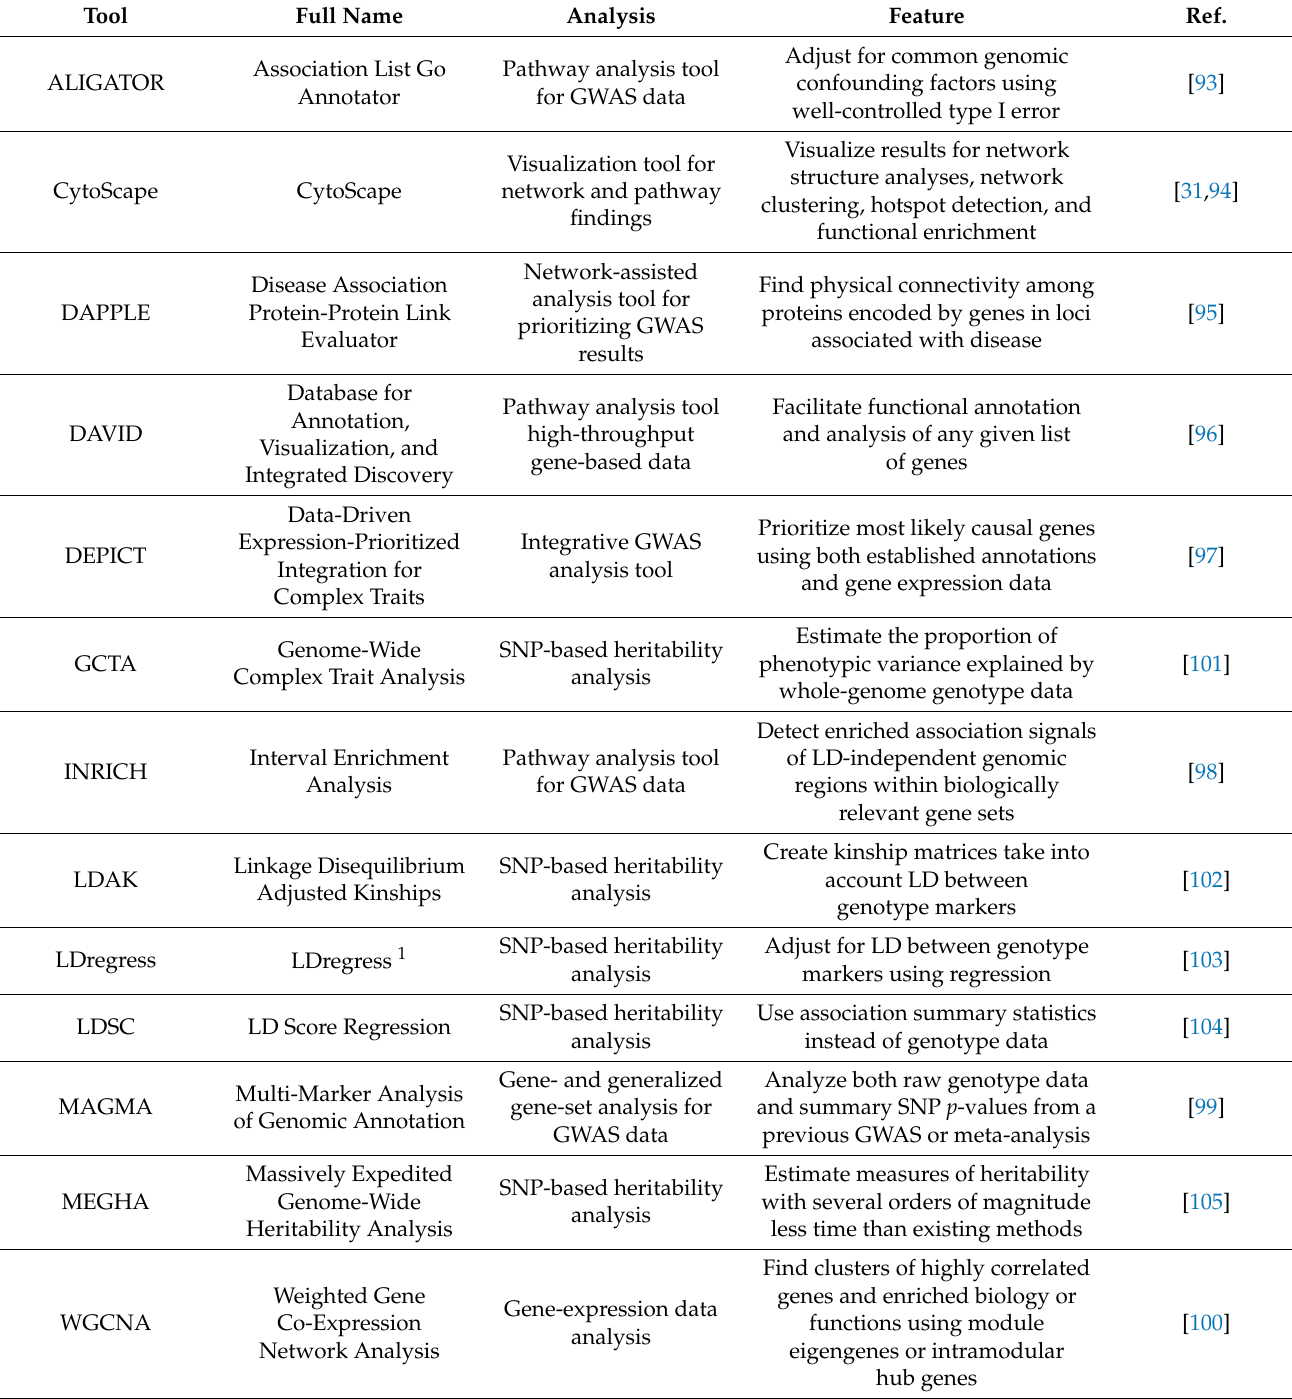
Table 2. Commonly employed computational and analytical tools in genome-wide association studies (GWAS) and sc/snRNA-seq